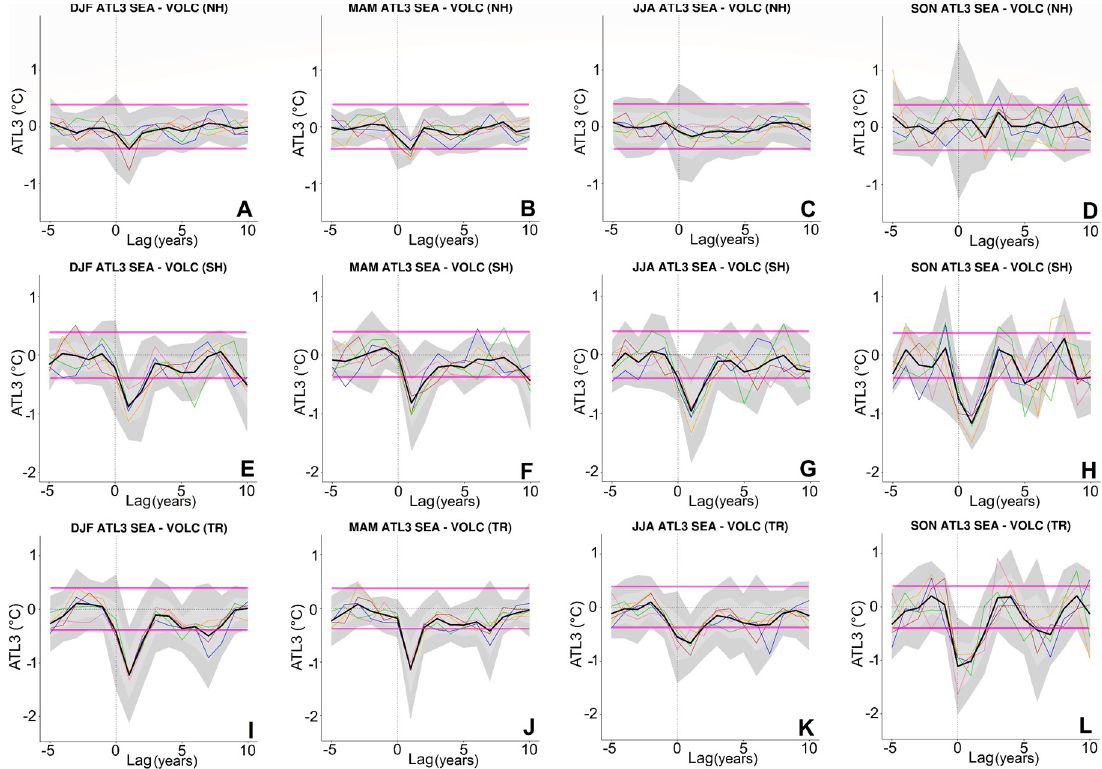
Figure 2. VOLC SEA for ATL3 SST seasonal anomalies (°C), calculated considering the volcanic eruptions listed in Table 1, for five years before the eruption, and ten years after the eruption. Horizontal: class of the eruptions (NH—( A – D ); SH—( E – H ); and TR—( I – L )); Vertical: seasonal SEA seasonal SEA (December to February—DJF; March to May—MAM; June to August—JJA; and September to November—SON). Lines in colors correspond to the individual ensemble members, and black thick line refers to the ensemble mean. Light shaded gray corresponds to one standard deviation, and dark shaded gray corresponds to two standard deviations. Magenta solid line corresponds to one standard deviation of the CTRL run.